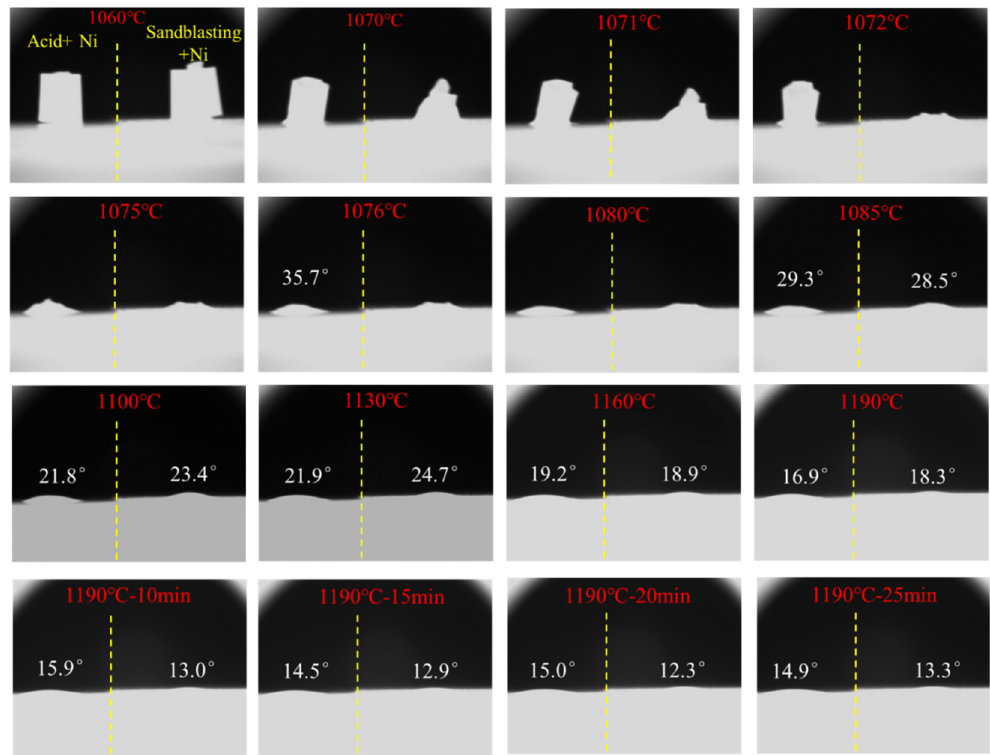
Figure 6. High-temperature contact angle on substrates of acid treatment + 10 μm Ni and sandblast- ing + 4 μm